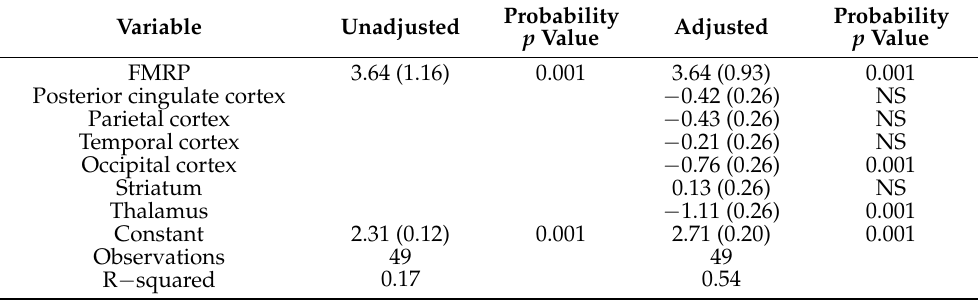
Table 5. Linear regression of 3-[ 18 F]fluoro-5-(2)pyridinylethynyl)benzonitrile ([ 18 F]FPEB) uptake on FMRP in men with a FM and an FXS-M of FXS with and without adjustment set to [ 18 F]FPEB uptake in the anterior cingulate cortex (ACC) as the baseline with standard errors in parentheses (StataCorp. 2021. Stata Statistical Software: Release 17. College Station, TX, USA: StataCorp LLC.) (Figure 3).